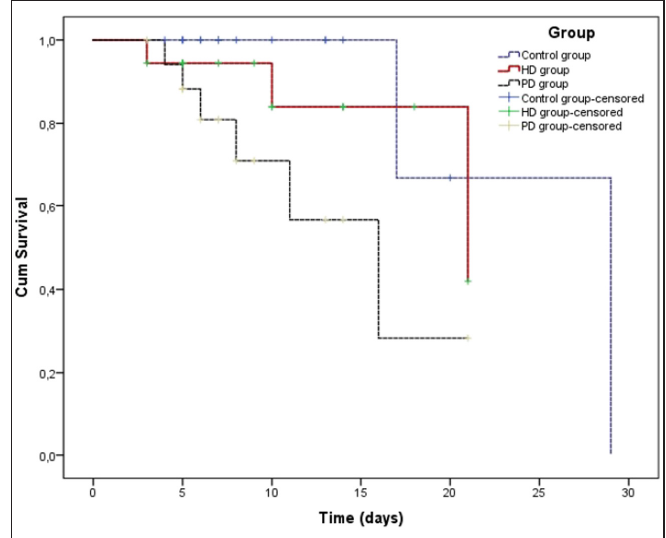
Figure 1. Kaplan–Meier plots of the patient according to the groups. The patient groups were compared in terms of the composite outcome. The median duration for the composite outcome was 29 days in the control group, 21 days in the HD group, and 16 days in the PD group (log-rank P values: control vs HD: .43; control group vs PD group: .22, HD group vs. PD group: .17). HD, hemodialysis; PD, peritoneal